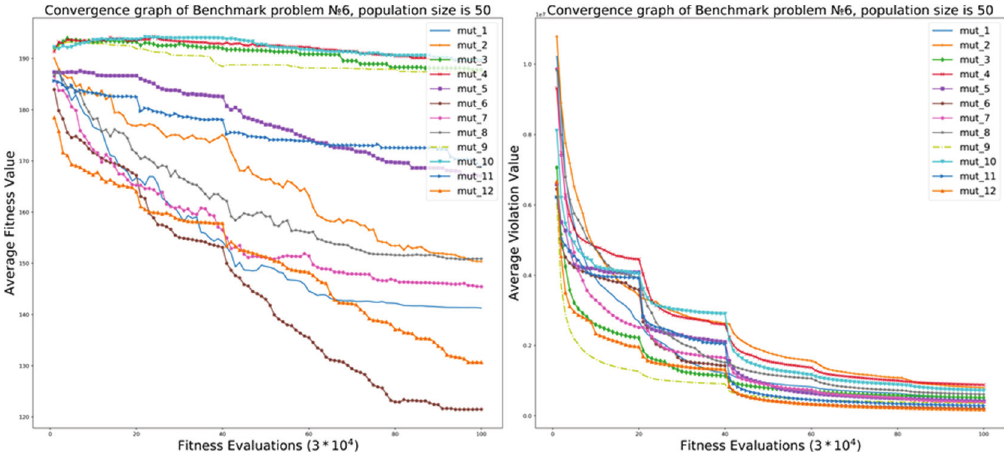
Figure 18. The performance of iCC framework on cLSGO benchmark Problem 6.